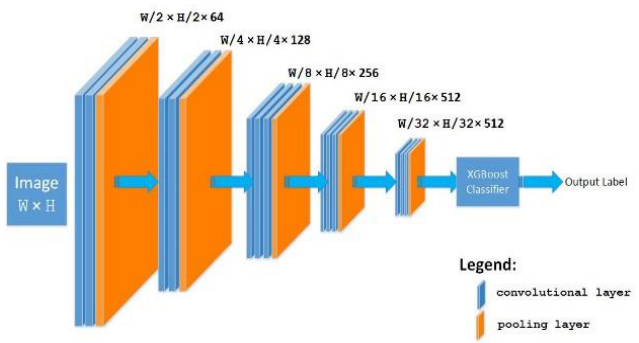
Figure 2. The architecture of our framework